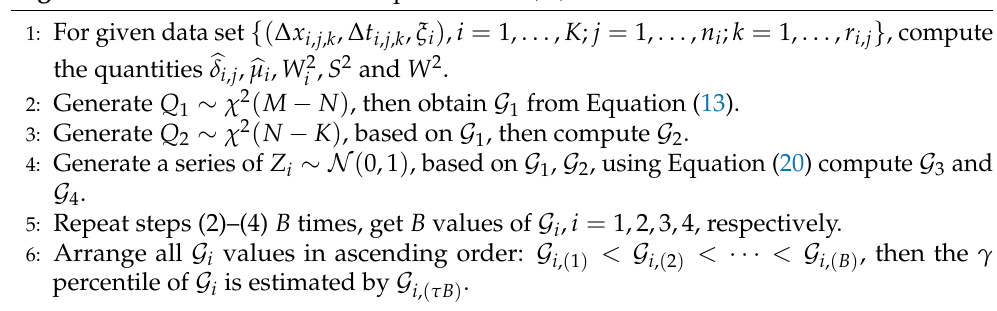
Algorithm 1 Percentiles for model parameters a , b , σ 2 and ω 2